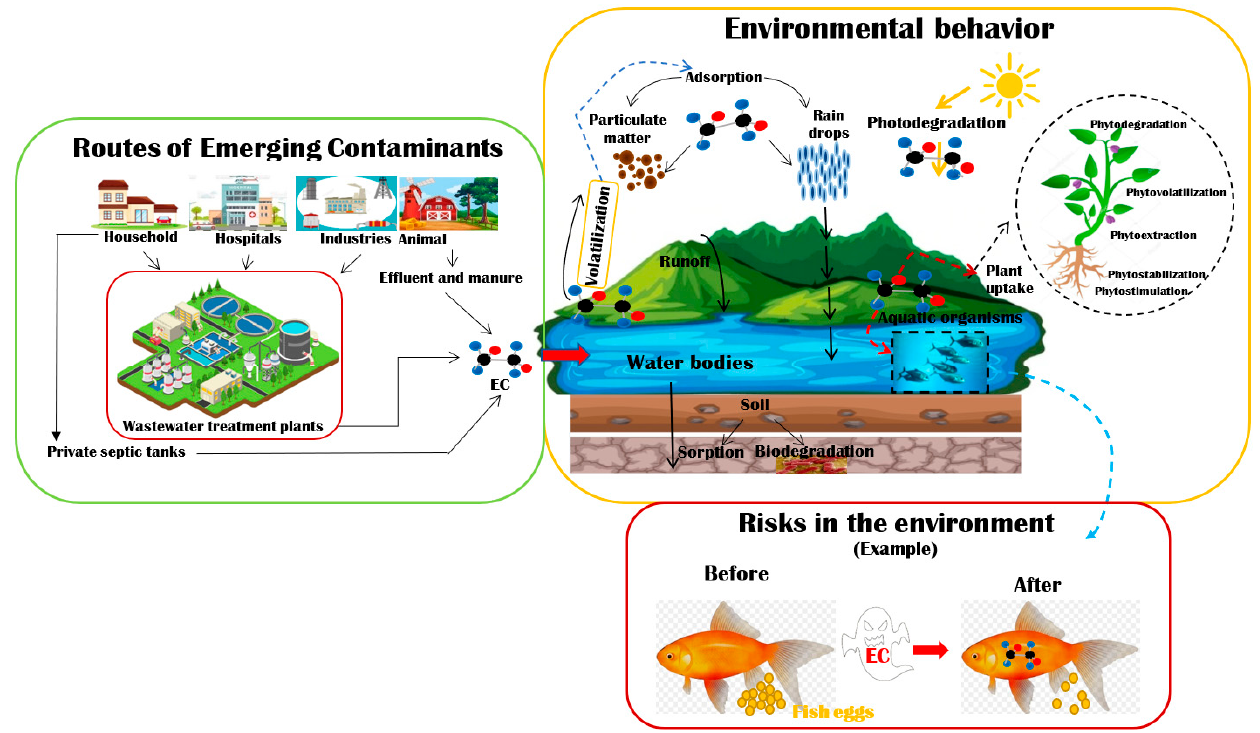
Figure 1. Routes of entry of ECs into the environment, its behavior, and e ff ects.